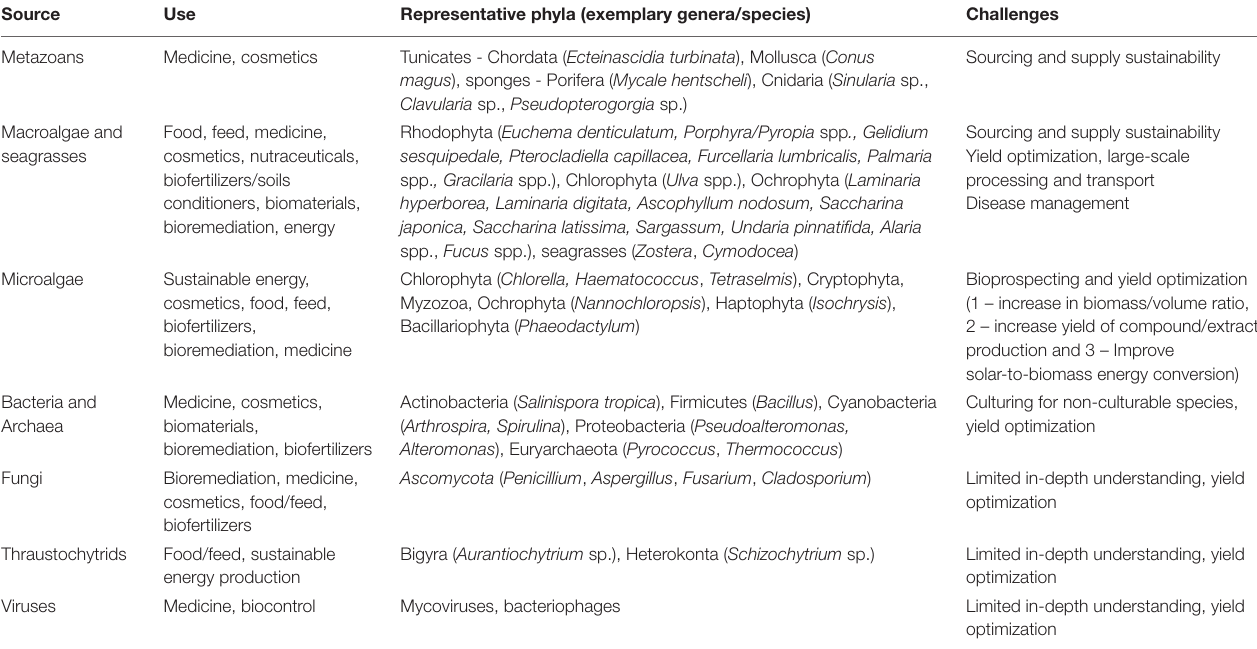
TABLE 1 | A non-exhaustive example list of the most prominent marine taxa, their use and challenges toward production scale-up.